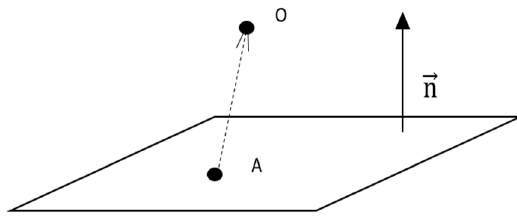
Figure 15. Relationship between a point and a cutting plane.